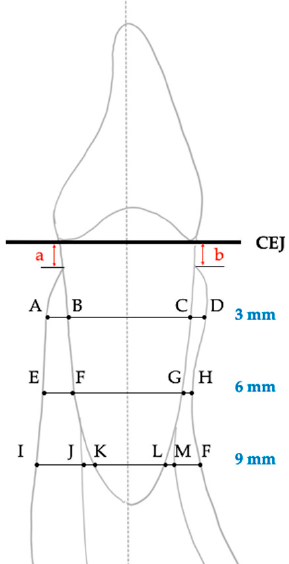
Figure 1. Cephalometric measurements. ( A ) The reference line was the long axis of the tooth. ( B ) Thicknesses were measured perpendicular to the long axis at 3, 6, and 9 mm apical to the CEJ. Heights were measured parallel to the tooth axis.